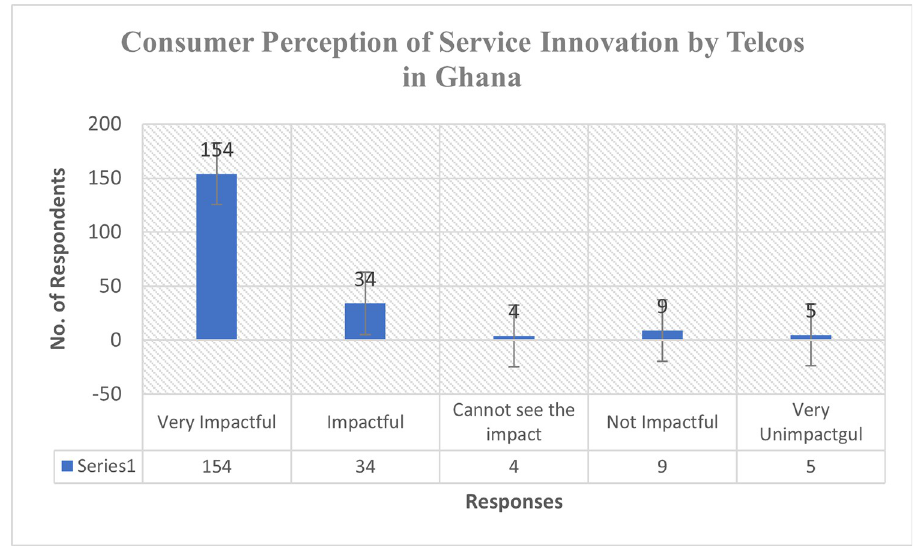
Fig 2. Customer perception of service innovations by Telcos in Ghana. Source: Field Survey (2021).